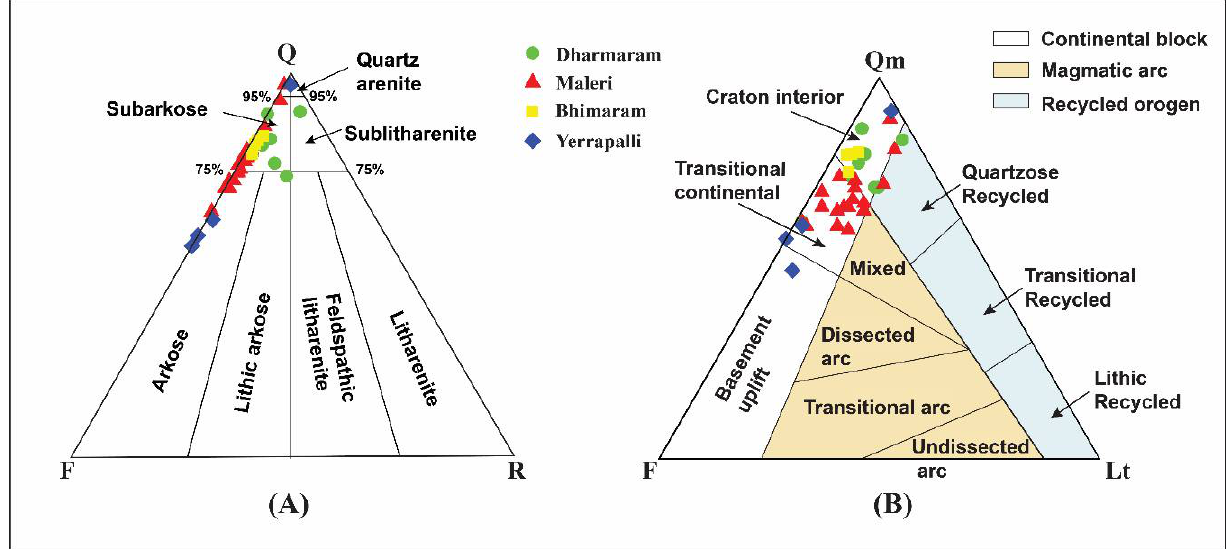
Figure 5. ( A ) QFR plot (adapted from [55]) and ( B ) QmFLt plot (adapted from [56]) for sandstone samples of Yerrapalli, Bhimaram, Maleri and Dharmaram formations (Q—total quartzose grains (Qt), including monocrystalline (Qm) and polycrystalline (Qp) varieties, F—total feldspar grains, R—total unstable rock fragments, L—total unstable lithic fragments, Lt—L +